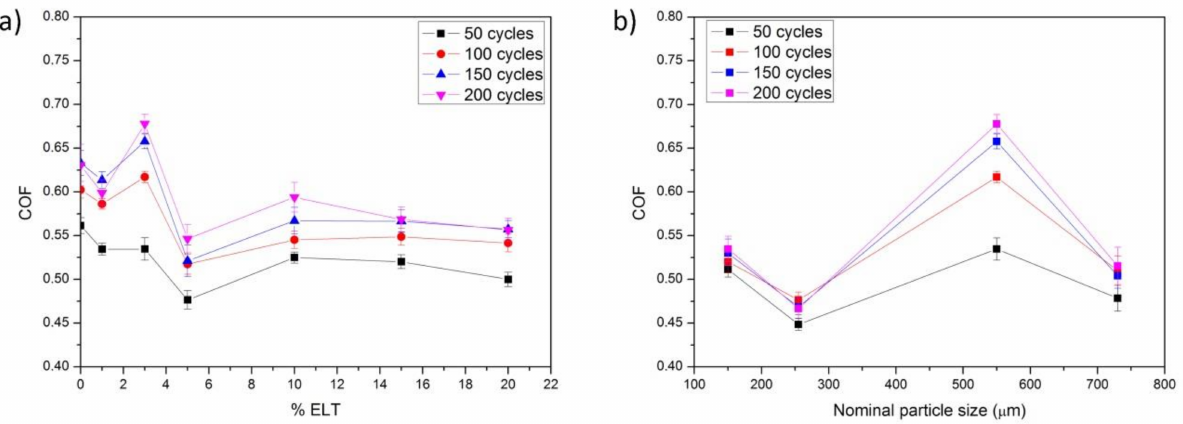
Figure 7. ( a ) COF of brake pads containing different concentrations of ELT rubber particles A60, and ( b ) COF of the brake pads containing 3% particles of different